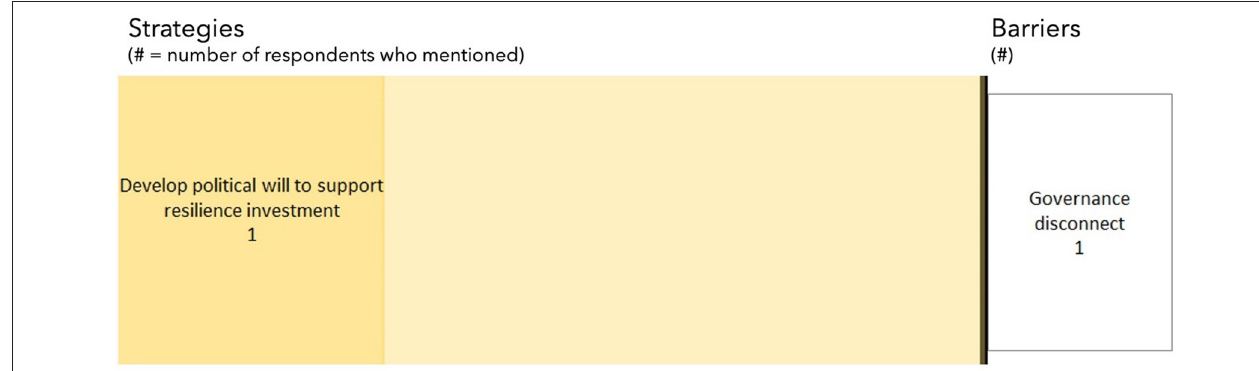
FIGURE 6 | Advocacy/lobbying strategy (left side) to overcome identified barriers (right side).